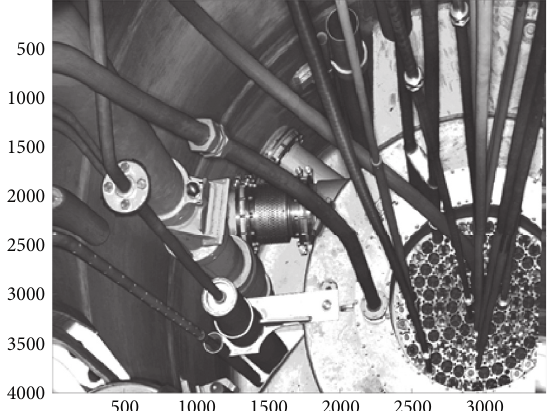
Figure 6: The 2D image of the TRIGA RC1 reactor vessel as acquired with the intensity channel of the device.